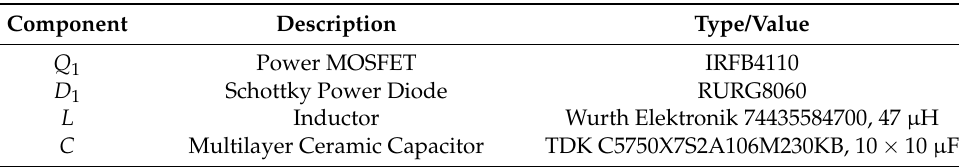
Figure 4. Experimental setup: ( a ) oscilloscope, ( b ) DC electronic device in CPL mode, ( c ) RT-Box with analog and digital breakout boards, ( d ) current probe power supply, ( e ) MOSFET driver power supply, ( f ) DC-DC boost converter, ( g ) current probes, ( h ) input voltage power supply, and ( i ) differential voltage probe. Table 1. Description of the boost converter’s